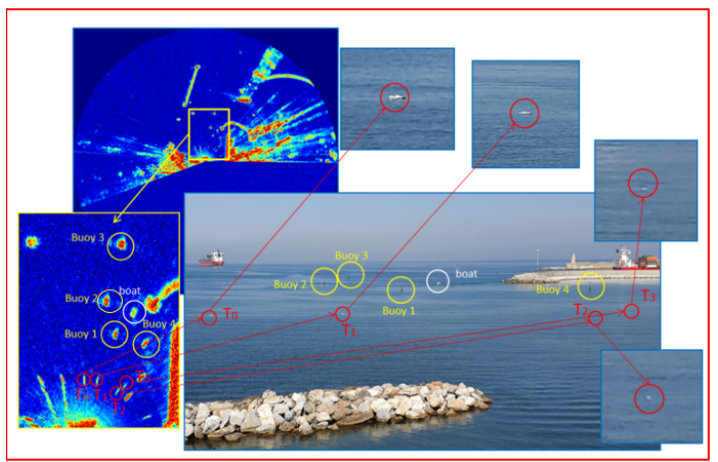
Figure 7. Radar and photographic representations of the first release of the targets.